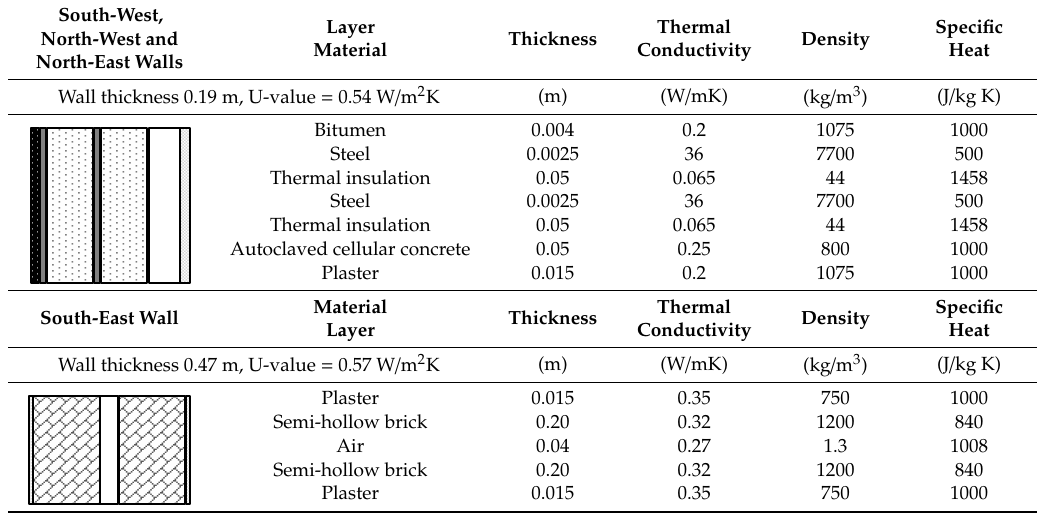
Table 1. Walls layers thickness and thermophysical properties (from outdoor to indoor).